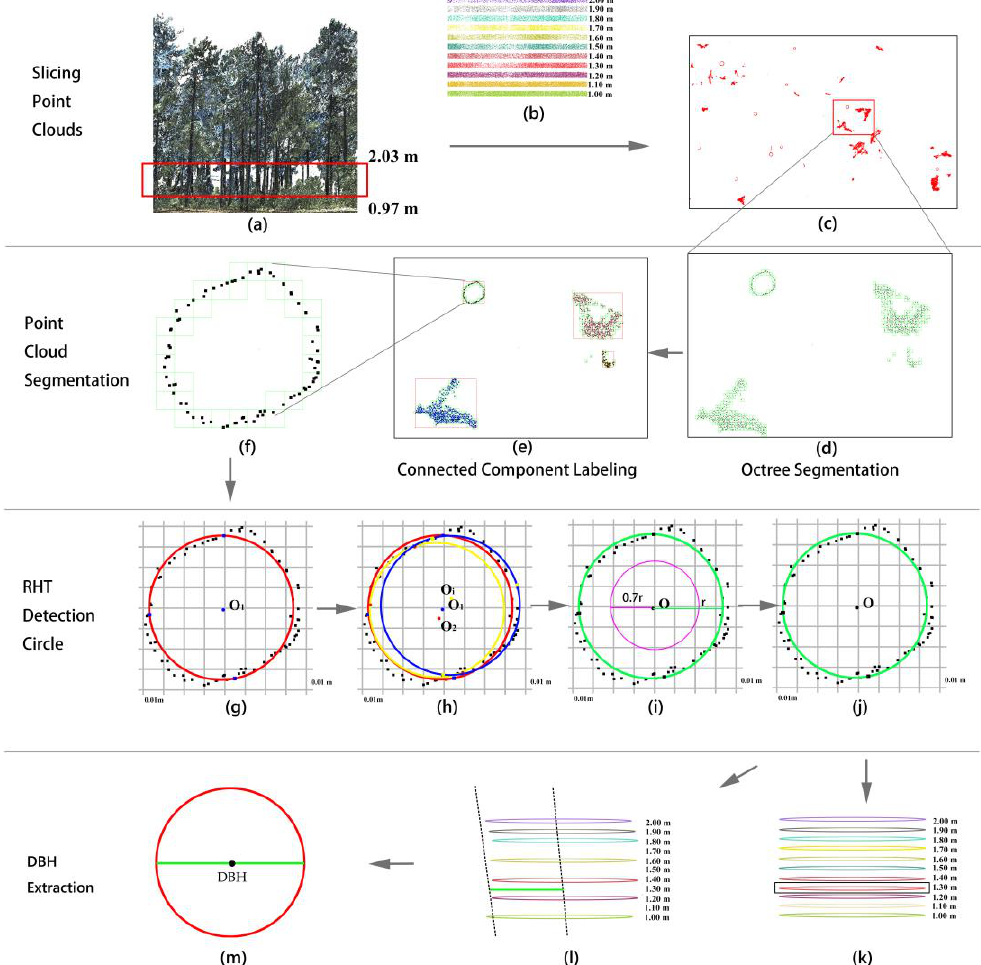
Figure 6. The detailed process of extracting DBH using random Hough transform. After extracting and slicing point cloud data from normalized data, each layer of point cloud is processed separately. Methods of octree segmentation and connected component labeling are used to segment each layer’s points. Finally, RHT method is used to extract the trunk and obtain the DBH.